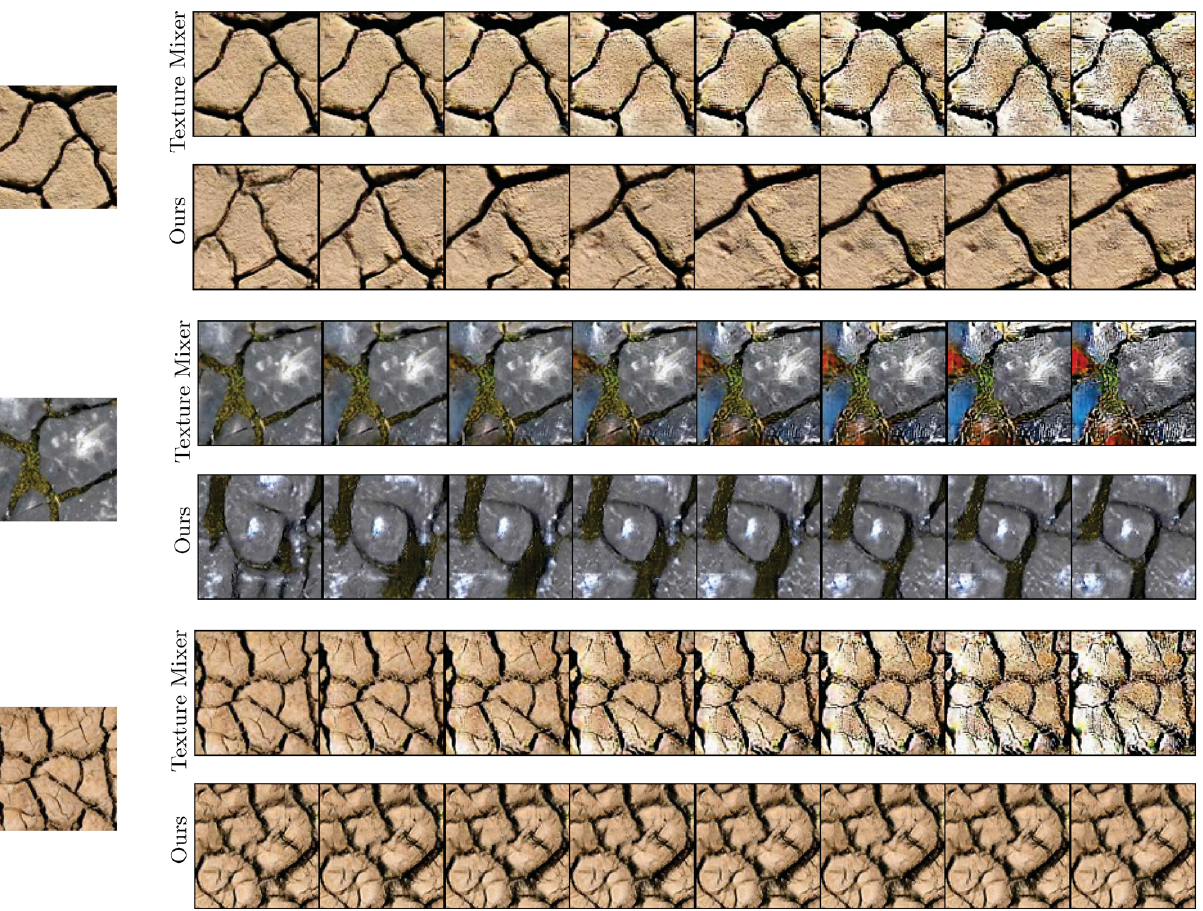
Fig. 9 Stability comparison. Given an input crop (left), we iteratively generate a sample with Texture Mixer [29] (top rows) and with our method (bottom rows). While Texture Mixer suffers from severe artifacts along the iterations, our texture synthesis method remains stable.